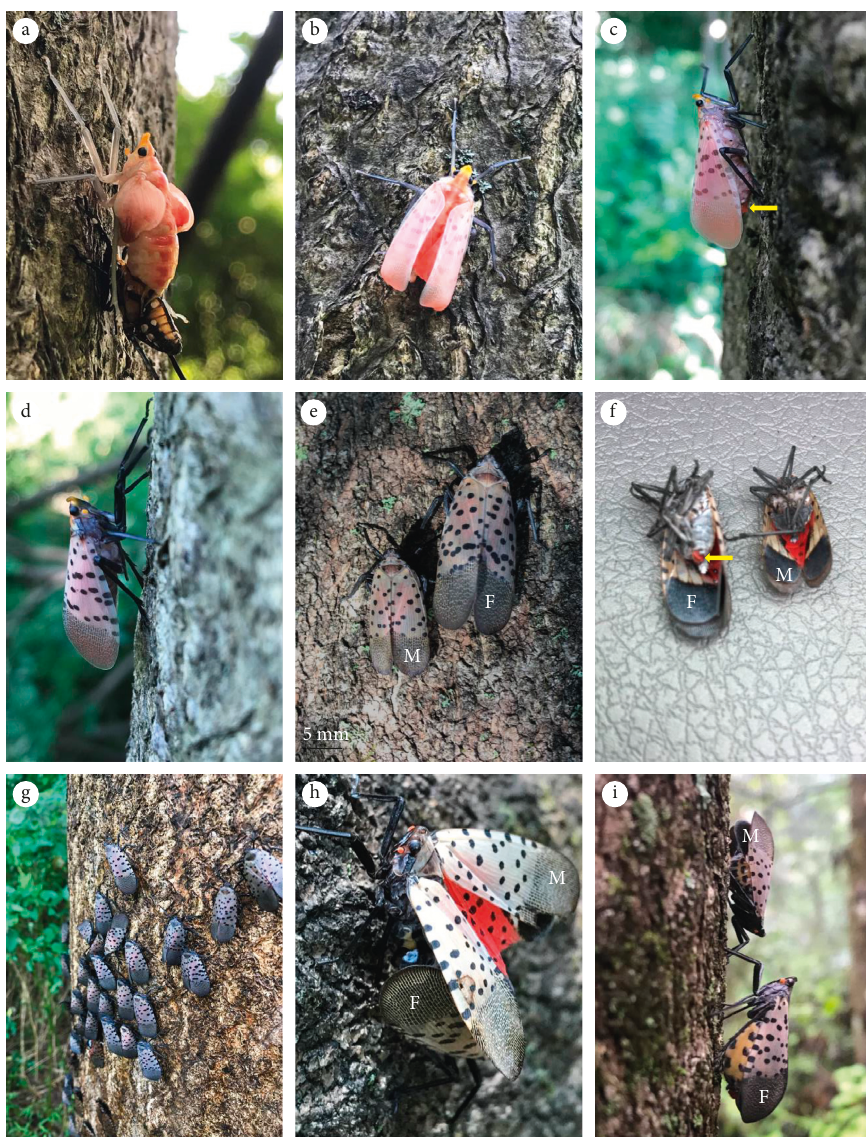
Figure 1: Lycorma delicatula adult development in the field. (a) An emerging adult with pink body, black compound eyes, yellow antennae and vertex, light-colored legs, and pink wing pads. (b) A newly emerged adult with expanding wings and black legs. (c) A full-fledged female with pinkish body and wings. (d) A fully sclerotized adult with darkening body and vertex. (e) Male versus female—dorsal view. (f) Female versus male—ventral view. (g) Multiple adults aggregating on trunk of tree of heaven. (h) A mating pair. (i) Mature male versus gravid female. Yellow arrows in (c) and (f) indicate red valvifers on female abdomen. M—male,